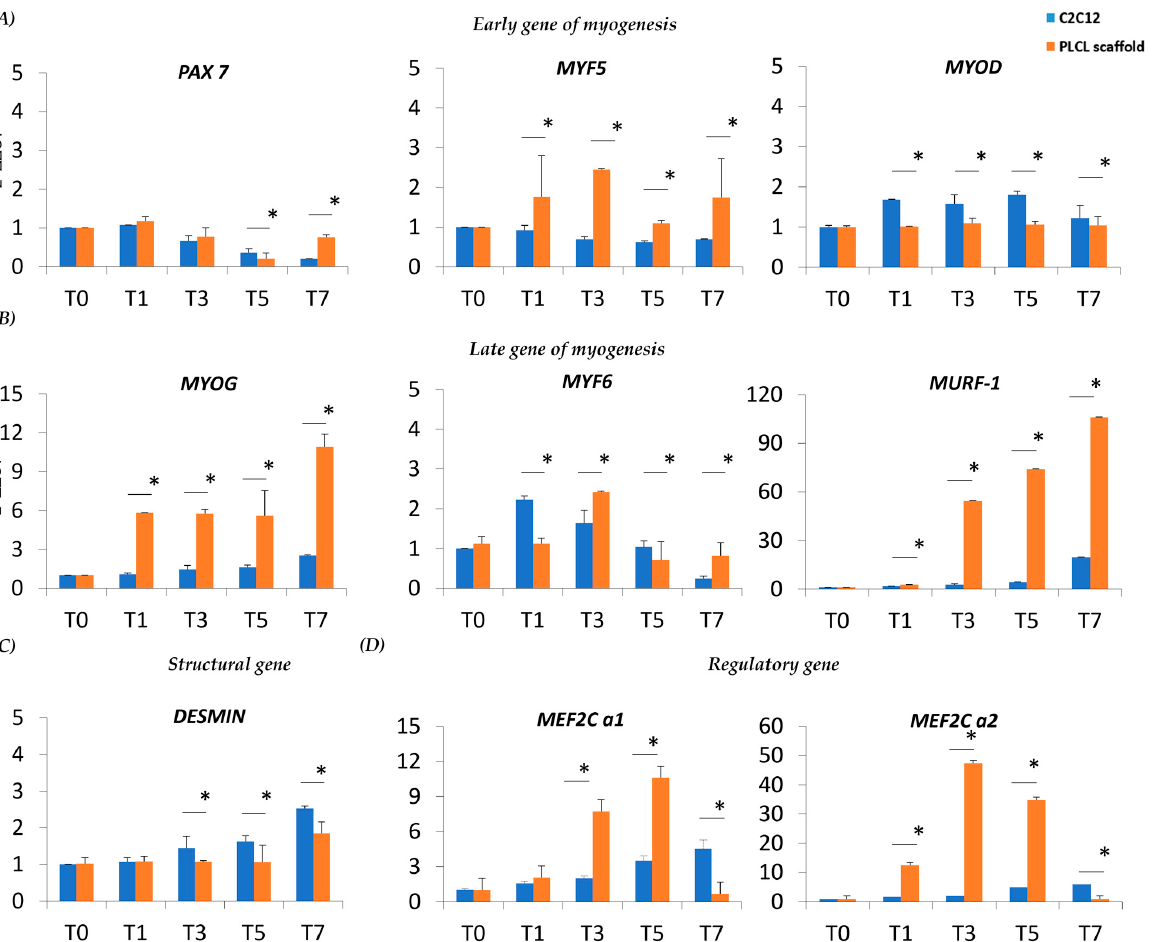
Figure 3. Real-time q-PCR of MRFs, muscle-specific proteins and MEF transcript levels in C2C12 on the scaffold and C2C12 control during myogenic differentiation. ( A ) Transcript levels of early MRFs and ( B ) late MRFs immediately after 24 h of differentiation (T1), during differentiation (T3–T5) and during late stages of differentiation (T7). ( C ) Expression of a structural gene after 24 h of differentiation (T1), during differentiation (T3–T5) and during late stages of differentiation (T7). ( D ) Expression of MEF after 24 h of differentiation (T1), during differentiation (T3–T5) and during late stages of differentiation (T7). * Data are representative of three experiments and expressed as means ± SD; the level of significance was set at p <